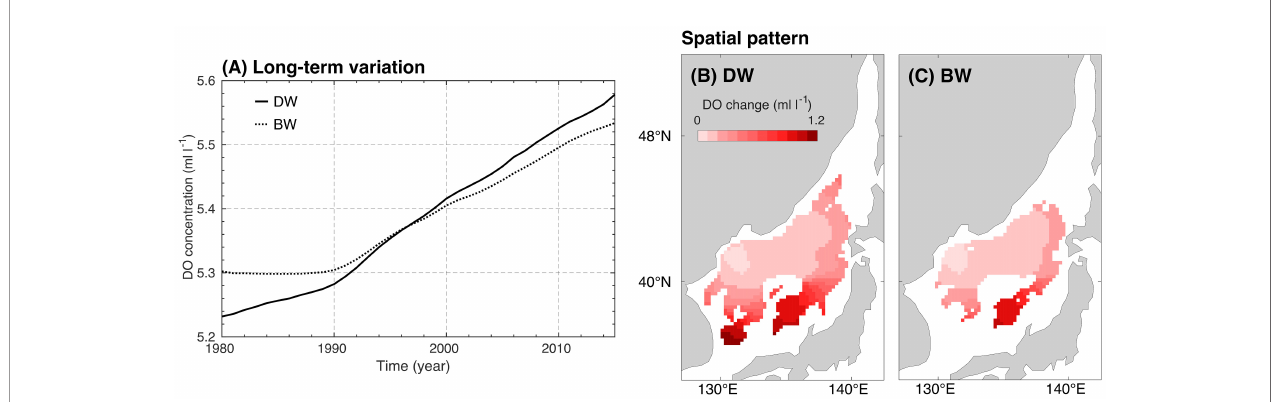
FIGURE 7 | (A) Long-term variation in the dissolved oxygen (DO) concentration of the no-ecosystem (NE) experiment. Solid and dotted lines indicate the DO concentration averaged in the East/Japan Sea from 1618 to 2250 m (deep water: DW) and 2250 m to the bottom (bottom water: BW), respectively. (B, C) Spatial distribution of the changes in the DO concentration simulated by the NE experiment for the 36-year period (1980 to 2015) in the DW and